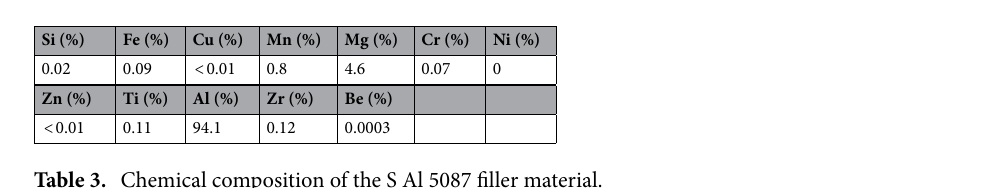
Table 3. Chemical composition of the S Al 5087 filler material.